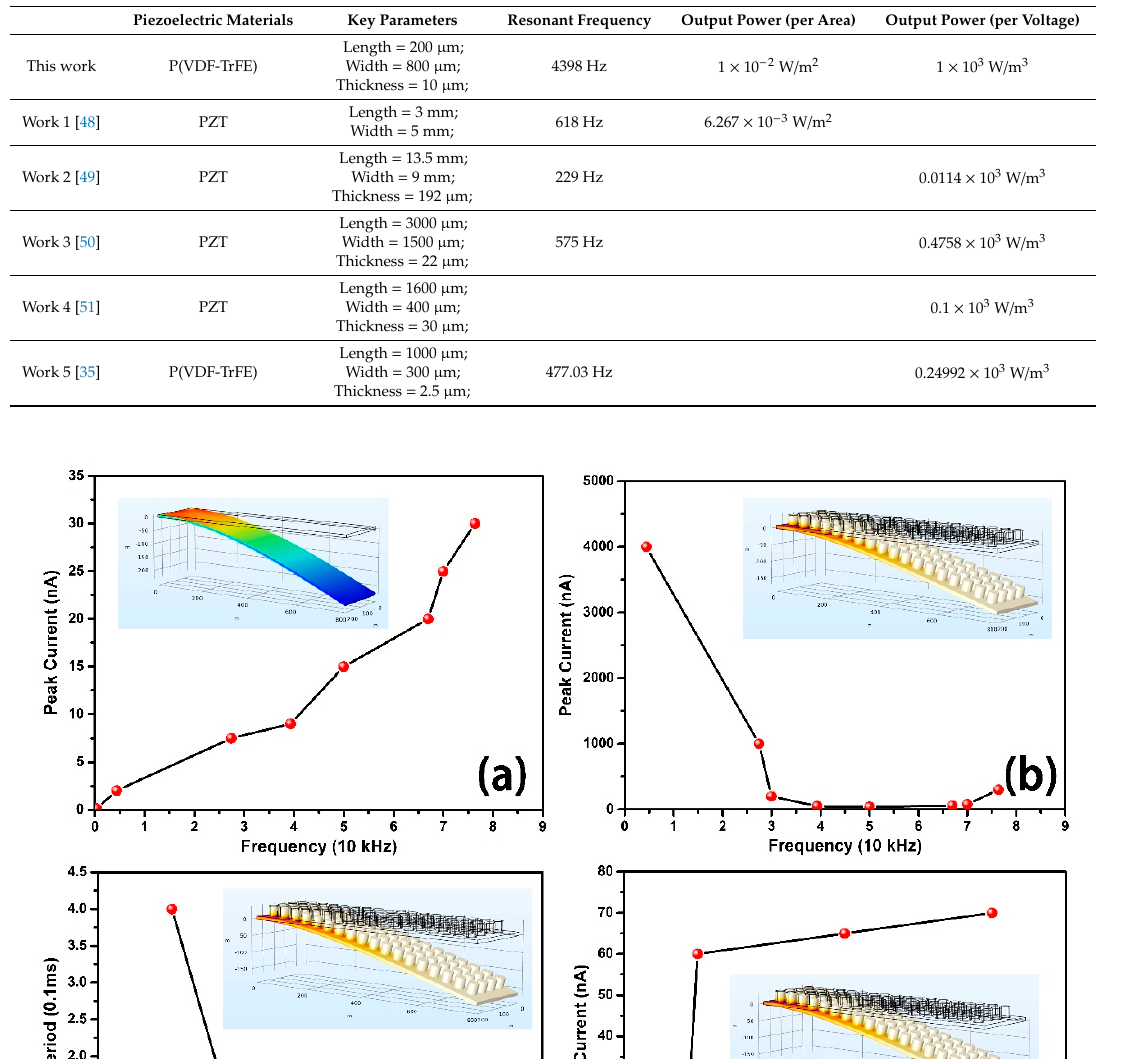
Table 2. Comparison of energy output between this research and previous research.